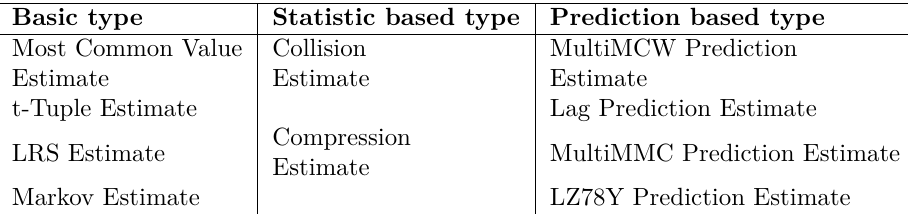
Table 1: Classification of NIST